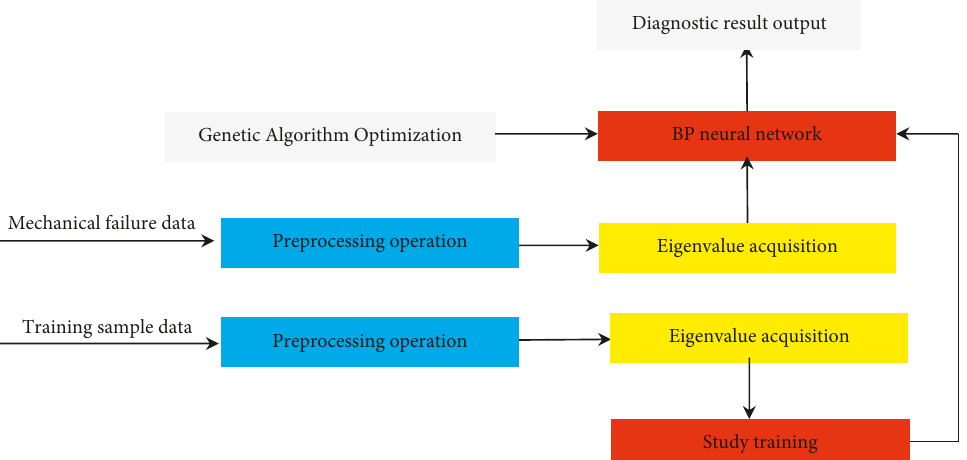
Figure 2: Design of identify structure based on GA-optimized neural network pattern recognition